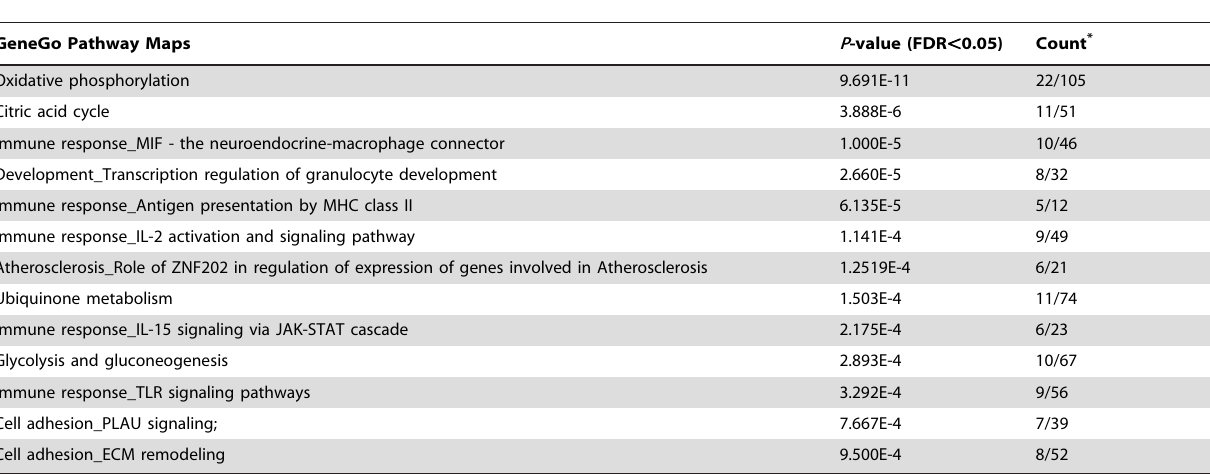
Table 3. GeneGo pathway maps over-represented in genes differentially expressed in flaxseed oil-fed mice compared to controls.